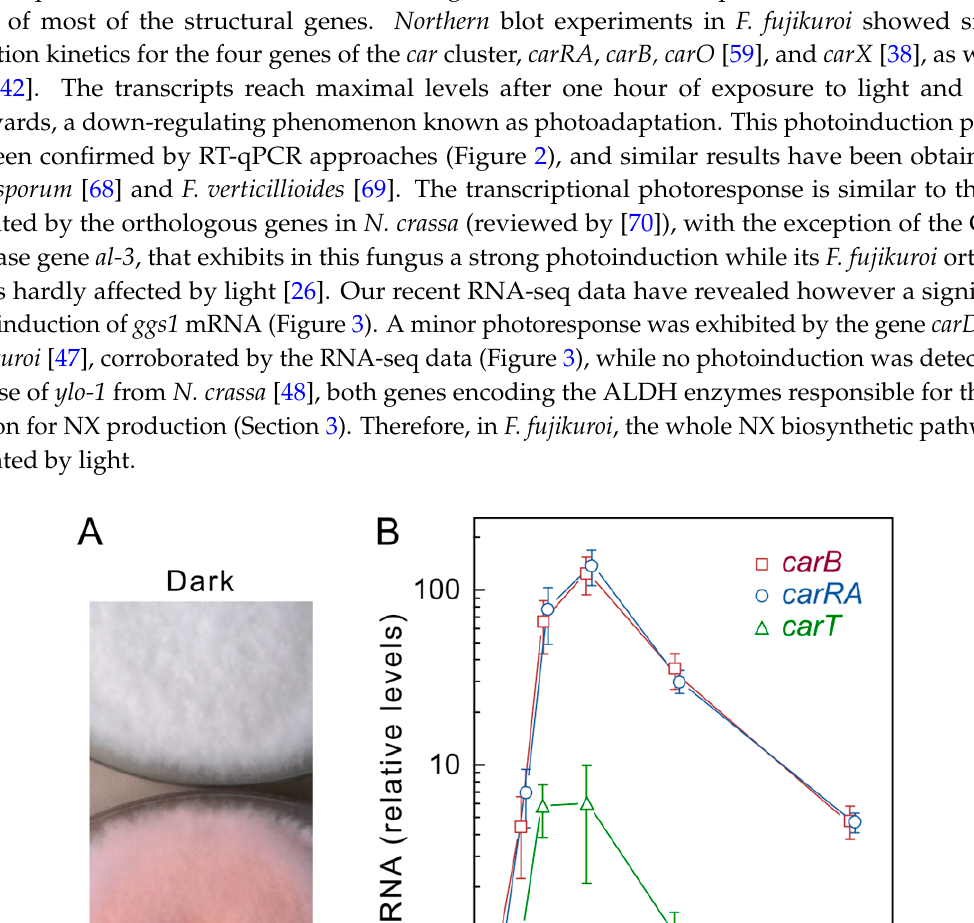
Figure 3. Effect of light and carS mutation on the expression levels for the Fusarium genes involved in carotenoid metabolism. The genes are grouped according to their functions: ggs1 , carRA , carB , carT, and carD involved in NX biosynthesis and carX and carO involved in retinal and CarO rhodopsin production. Orange colors correspond to the genes organized as a cluster, and blue color to genes